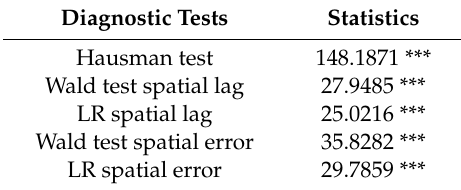
Table 4. Diagnostic tests for SPDM with two-way FE.